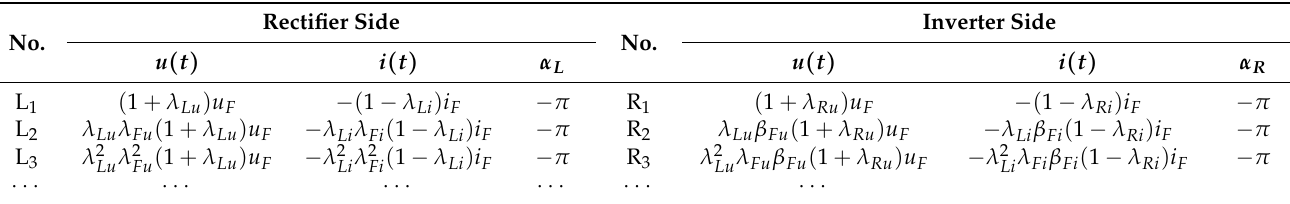
Table 1. Two terminals’ TW mutations with internal fault.